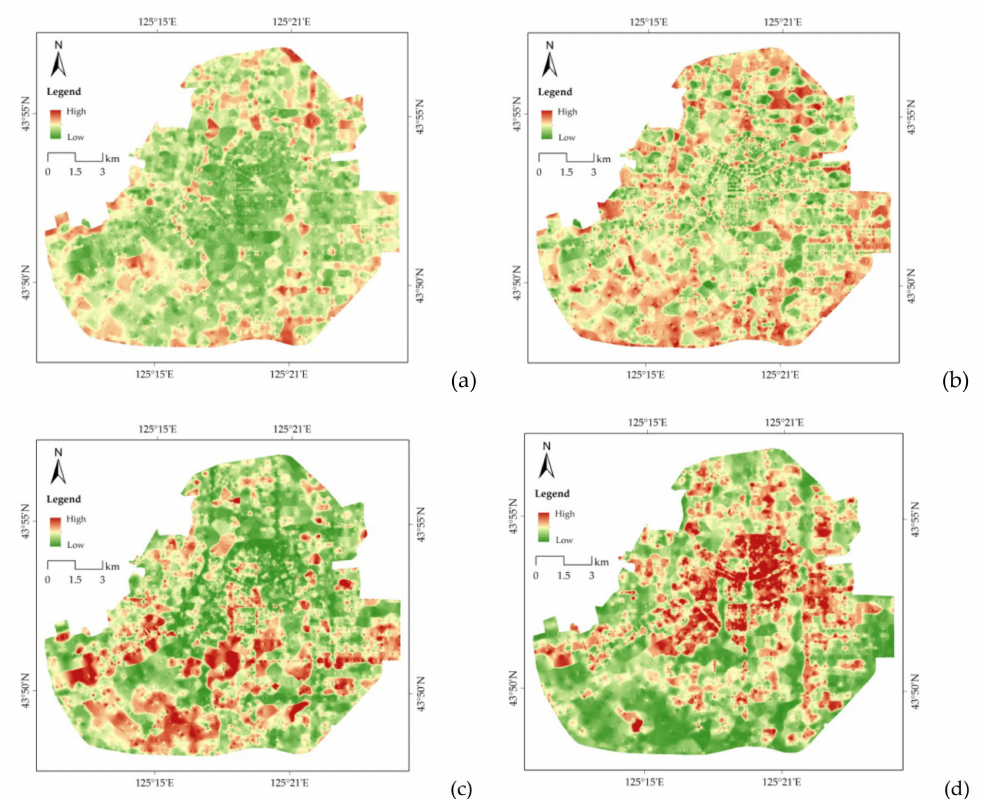
Figure 6. Spatial distribution characteristics of the street view elements. ( a ) Sky; ( b ) roads; ( c ) vegetation; ( d ) buildings.